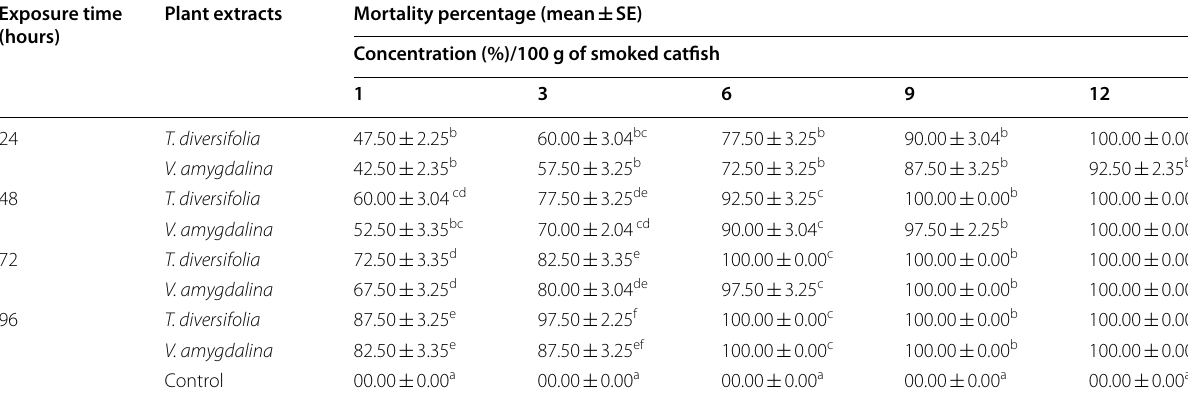
Mean followed by the same letters within the same column are not significantly different ( P >0.05